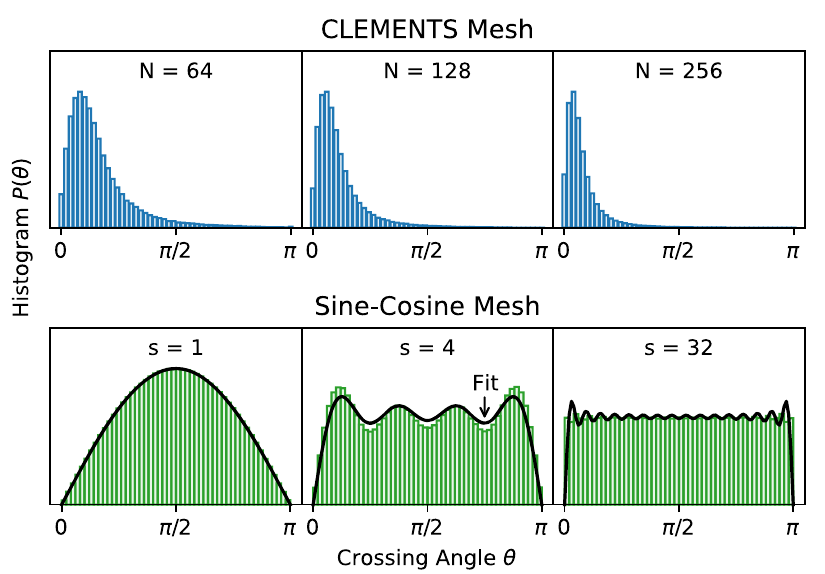
Figure 2: Distribution of crossing angles for the Clements , Reck and SCF meshes as a function of mesh size and stride, respectively. The crossing angles of the Clements mesh and the Reck mesh increasingly clusters near 𝜃 = 0 for larger meshes. Crossing angles for the SCF mesh become increasingly uniformly distributed as the stride